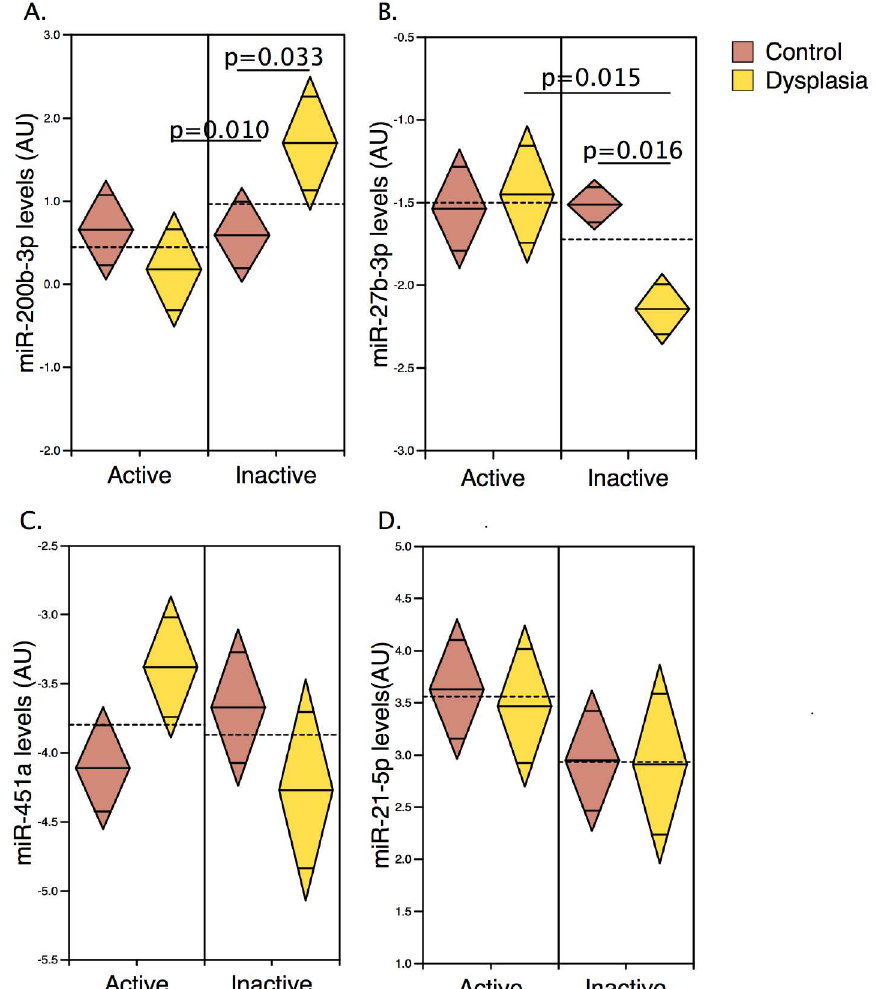
Fig 2. qPCR validation of miRNAs associated with ulcerative colitis-dysplasia. qPCR validation of miRNAs associatedwith UC-DYS. (A-D) qPCR analysisof miR-200b-3p, miR-27b-3p, miR-451aand miR-21- 5p expressionlevels, in an expanded validationUC cohort. Significantdifference were determinedby two- ANOVA and the data are presentedas a two-way diamondmean comparison plot. The horizontal dashed line represents the overall mean. The line through the centre of each diamondcorresponds to the individual groupsmean. The top and bottom diamondvertices indicatethe respectiveupper and lower 95% confidence limits of the group